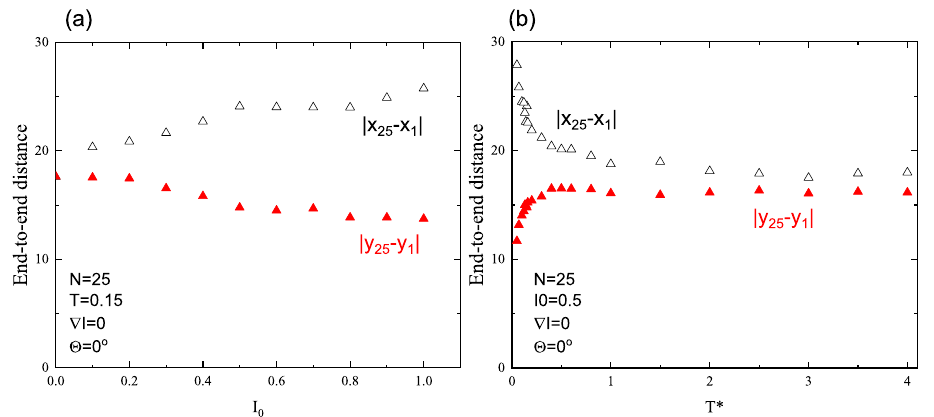
Figure 4. Averaged end-to-end distance after illumination time of 10 4 MCS as function of: light intensity I 0 ( a ); and temperature T ∗ ( b ) ( I 0 = 0.5). In both cases, Θ = 0 ◦ . Experimental errors are of the size of graphical